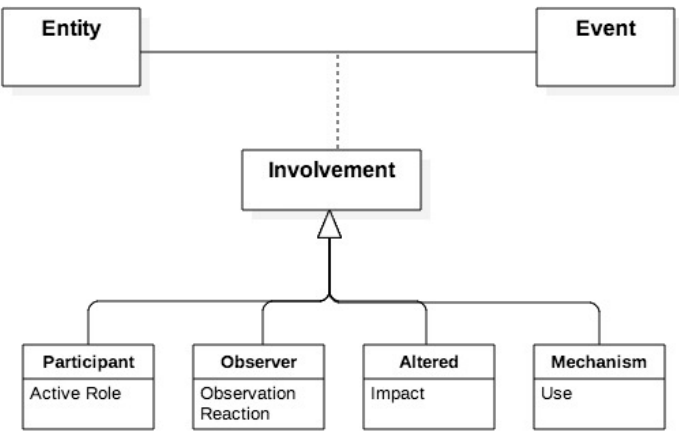
Figure 3. Entity Involvement in Event. Every Event must involve at least one Entity. An Entity may be involved in different ways, such as actively participating, observing, being impacted or being